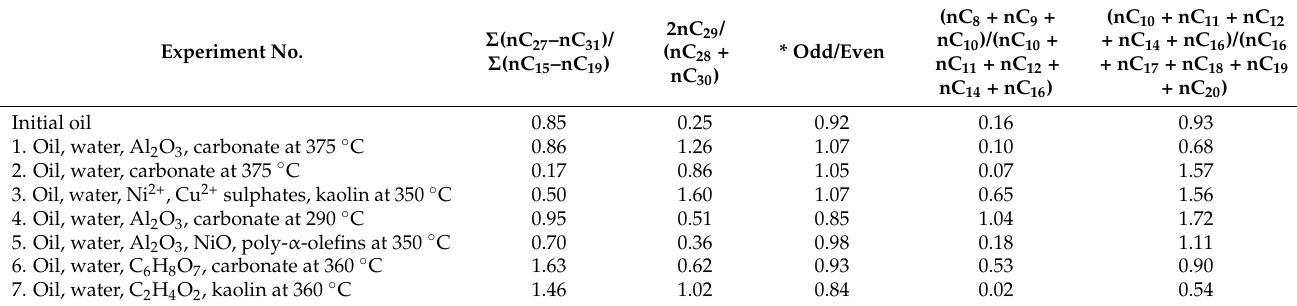
Table 4. Geochemical coefficients of the original and converted oil (continued).